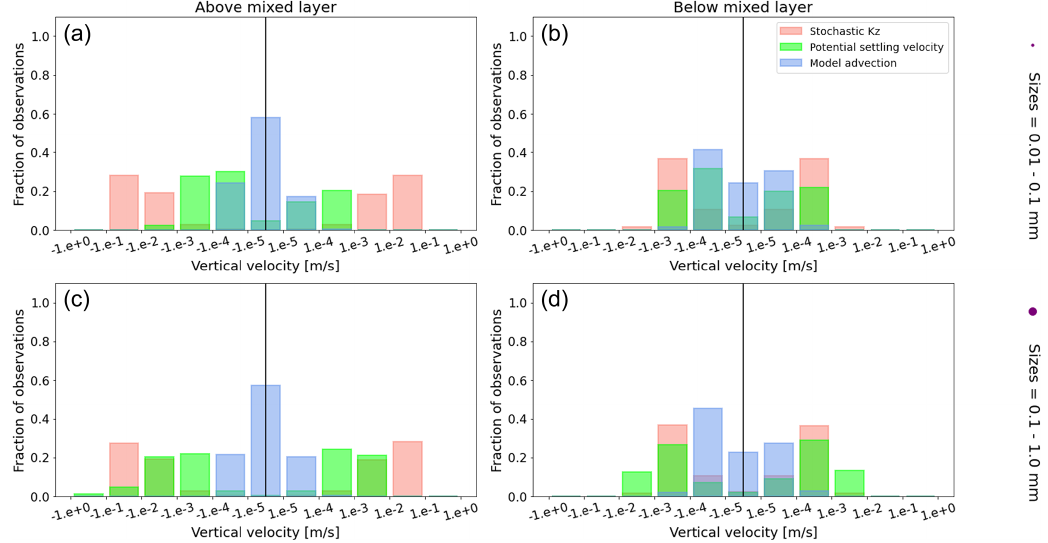
Figure A1. Equatorial Pacific’s annually averaged vertical velocities [ms − 1 ]. Stochastic K z (red) which comprises of tidally induced mixing and wind-driven mixing; potential settling velocity of the particle (green), which is w s in Eq. (5); and NEMO-MEDUSA vertical advection (blue). The top row is for particles of the smallest size class (0.01–0.1mm), and the bottom row is the largest size class (0.1–1mm). The left column is for particles within the wind-mixing region (above the mixed layer), and the right column is for particles below the mixed layer. The vertical black line represents a vertical velocity of 0; to the right of that line is for upward velocities, and to the left is for downward velocities, with each bar indicating an increase by an order of